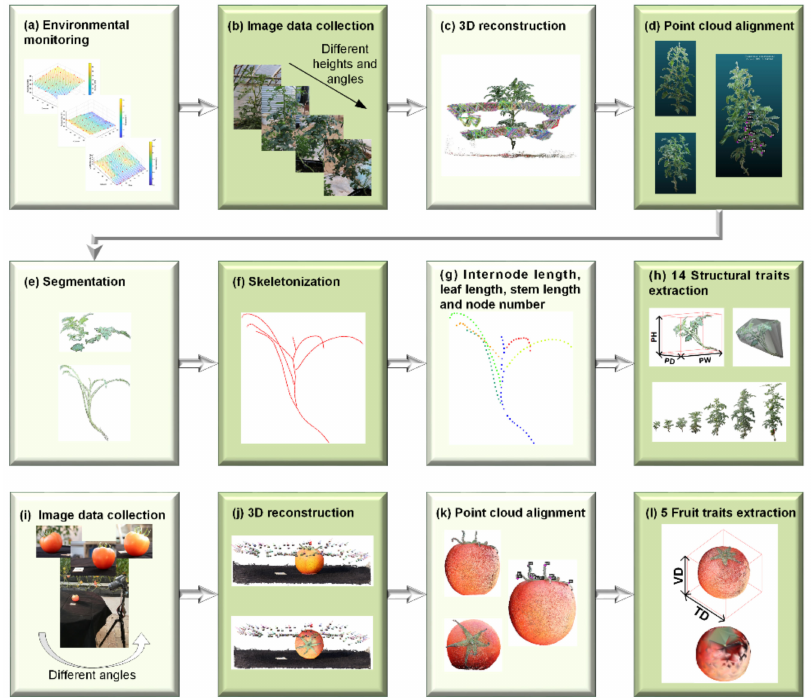
Figure 1. 3DPhenoMVS: A structural phenotypic trait estimation and growth analysis pipeline for tomato plants, covering the whole life cycle. ( a ) Environmental monitoring to determine the target plants, ( b ) image data collection to obtain multiview image sequences, ( c ) 3D reconstruction from images to generate 3D point clouds, ( d ) point cloud alignment to output a complete tomato plant model, ( e ) stalk and leaf point cloud segmentation to separate stalk point clouds and leaf (except petiole) point clouds, ( f ) skeletonization of stalk point clouds, ( g ) phenotypic trait extraction and visualization based on the skeletonization results, ( h ) extraction and analysis of structural phenotypic traits, ( i ) image data collection to obtain multiview image sequences, ( j ) 3D reconstruction, ( k ) point cloud alignment to obtain a complete tomato fruit model, ( l ) extraction of 5 fruit phenotypic